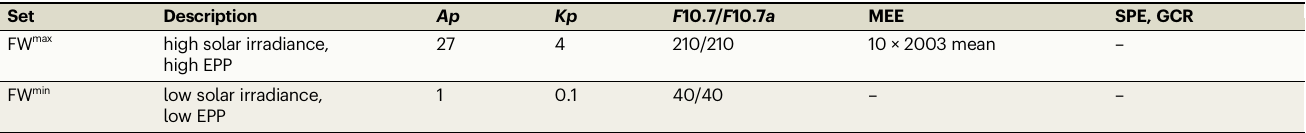
Table 1 | Solar irradiance and energetic particle precipitation (EPP) forcing terms for the idealized experiments labeled FW max and FW min Set